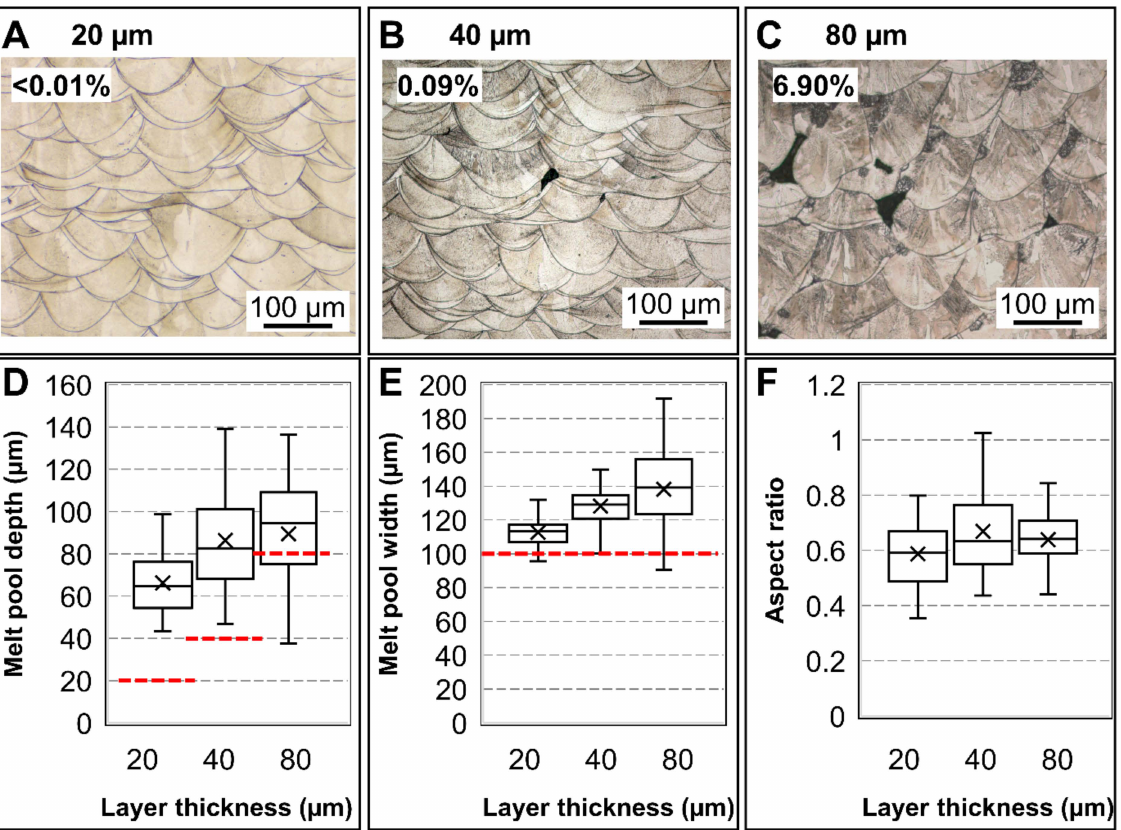
Figure 13. Influence of layer thickness on melt pool geometries and flaw populations in the conduction regime. Microstruc- ture of specimens manufactured with layer thickness of: 20 µ m ( A ); 40 µ m ( B ); 80 µ m ( C ); otherwise identical parameters (nominal laser power 200 W and scan speed 1000 mm/s). The volume fraction of flaws is indicated. Distribution of melt pool: depths ( D ); widths ( E ); aspect ratios ( F ) for the three levels of layer thickness. The red dashed lines represent the nominal layer thickness ( D ) and hatch spacing ( E ) used in